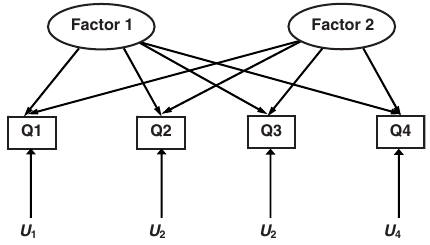
FIG. 8. Common factors and unique factors in common factor